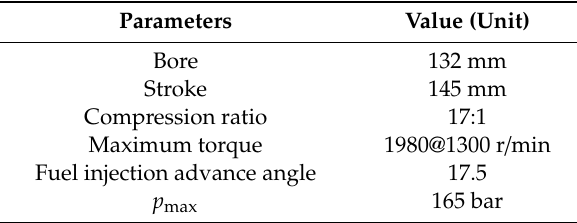
Table 1. Engine parameters of original